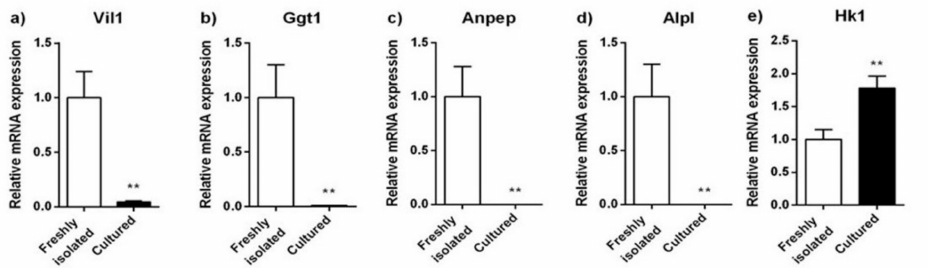
Figure 4. Relative mRNA expression of the tubule marker proteins Vil1 ( a ), Ggt1 ( b ), Anpep ( c ), Alpl ( d ) and Hk1 ( e ) in freshly isolated and cultured PRPTCs. The mRNA expression of each gene was normalized to Gapdh expression and is shown in reference to the expression level of each gene in freshly isolated PRPTCs, which was set to 1. Each bar represents the mean ± SD ( n = 3), ** p <